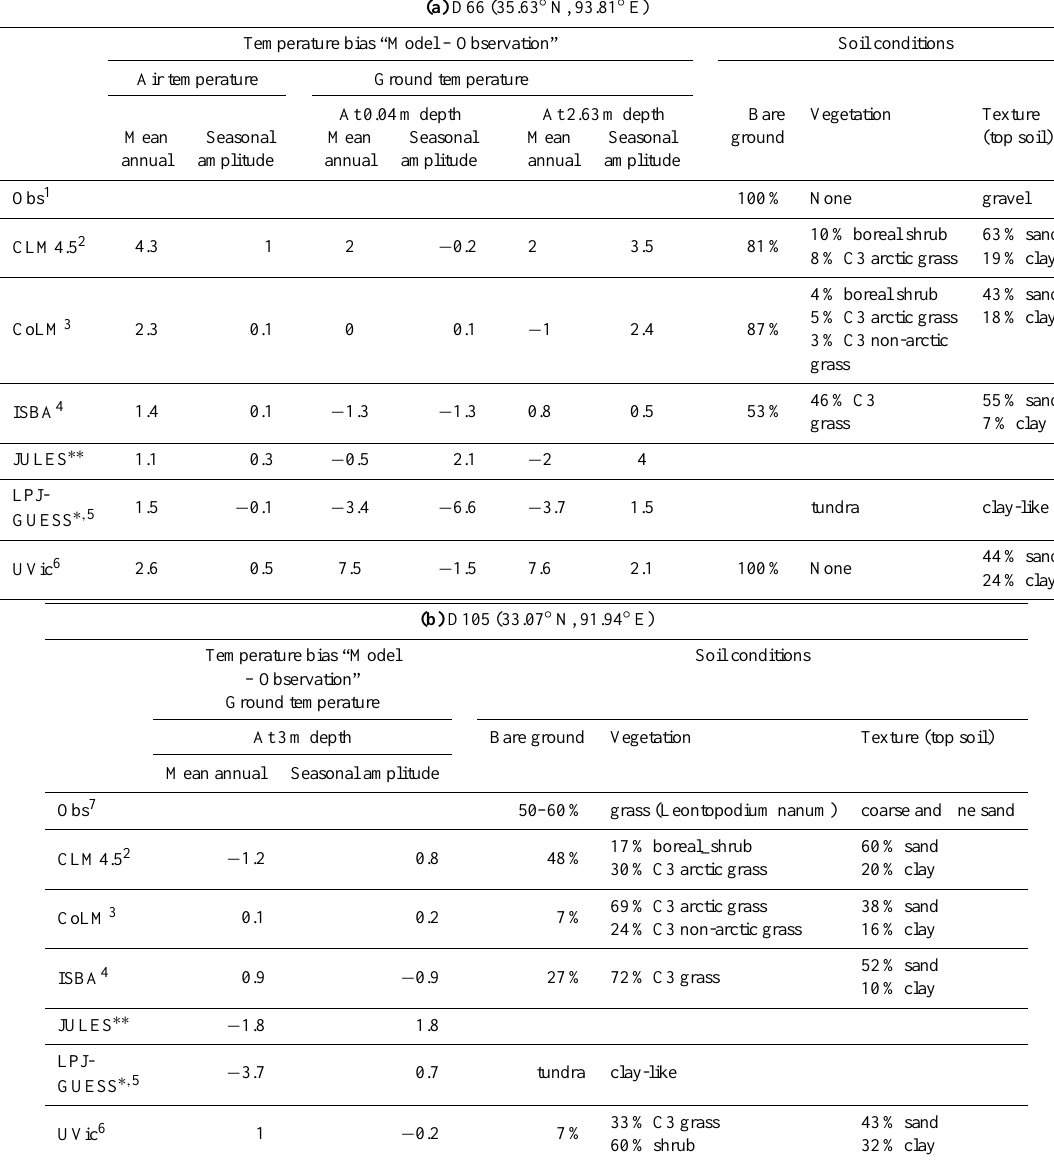
Table 4. Model-observed temperature differences in mean annual and seasonal cycle amplitude of air and soil temperature, based on data from 1996 to 2000 (Sect. 3.4; Fig. 4), and the corresponding vegetation and soil properties of both observation and models. Air temperature data are only available for D66 station and limited from September 1997 to August 1998. Thus the statistics of ground temperature of D66 is also confined to this